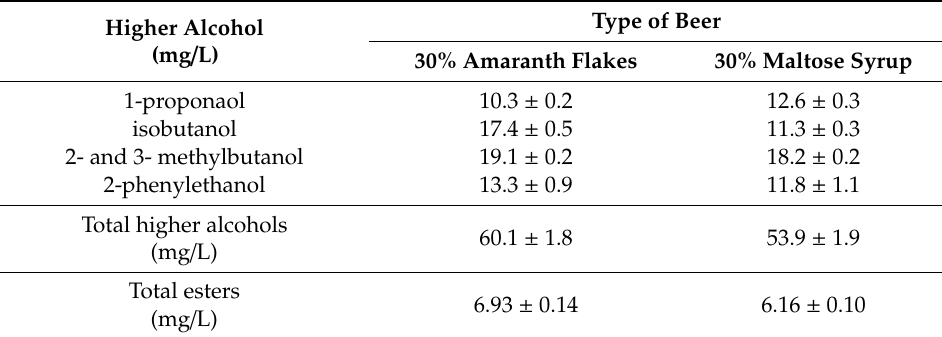
Table 4. The concentration of the higher alcohols and esters in